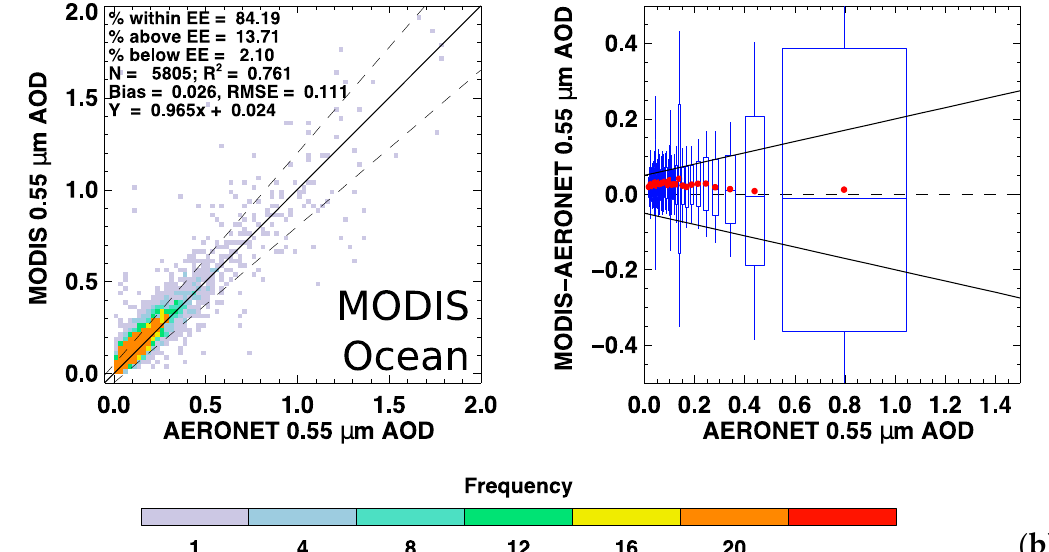
Figure 1. Comparison between Dark Target and the Aerosol Robotic Network (AERONET) for 0.55 μ m aerosol optical depth (AOD) over ocean for all collocated measurements in 2015 using ( a ) VIIRS SNPP and ( b ) MODIS Aqua.